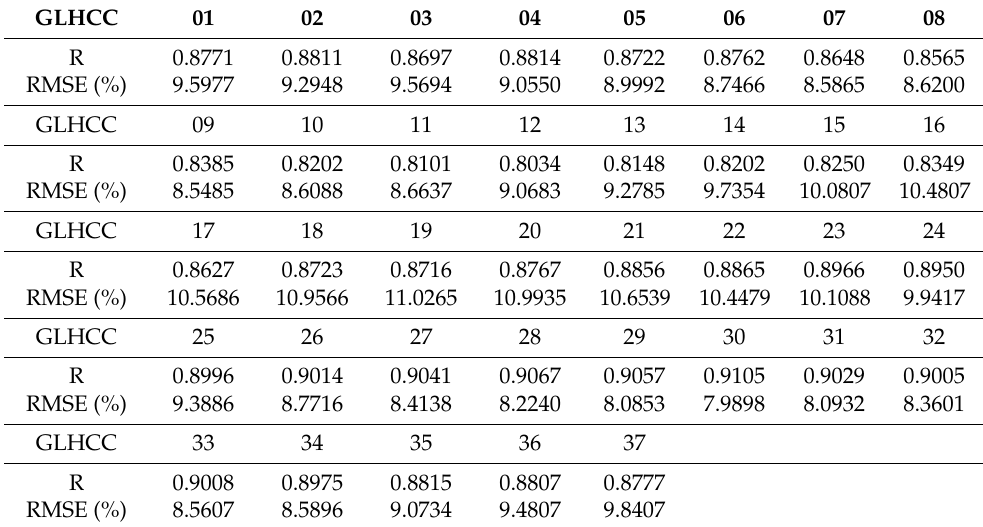
Table 1. Statistical table of correlations between observation data and the